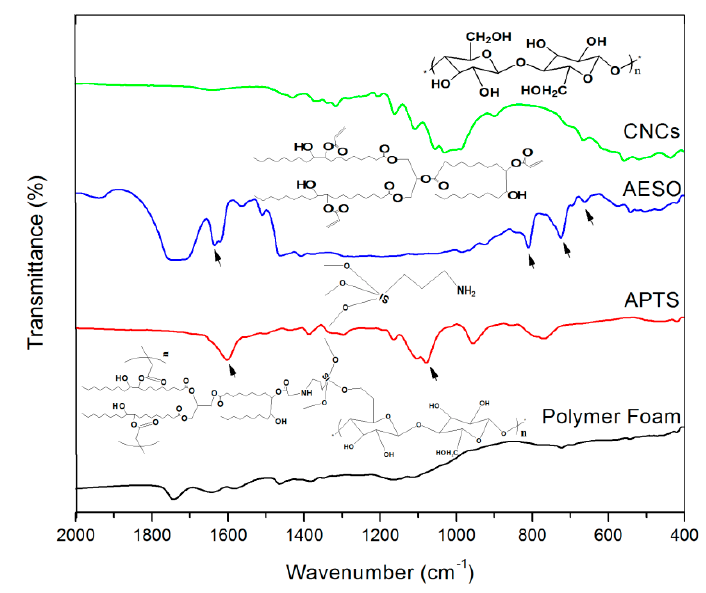
Figure 6. FT-IR spectra of CNCs, AESO, 3-aminopropyltriethoxysilane (APTS), and nanocomposite polymer foam.